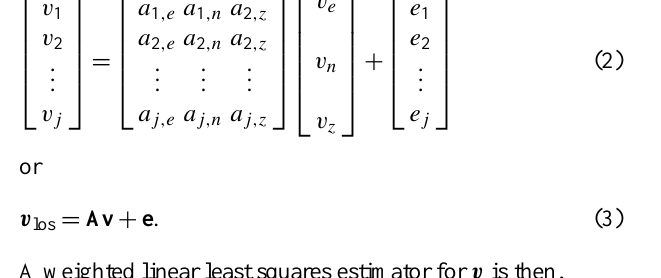
Table 1. Beam directions used for simulation and experiment. Beam map